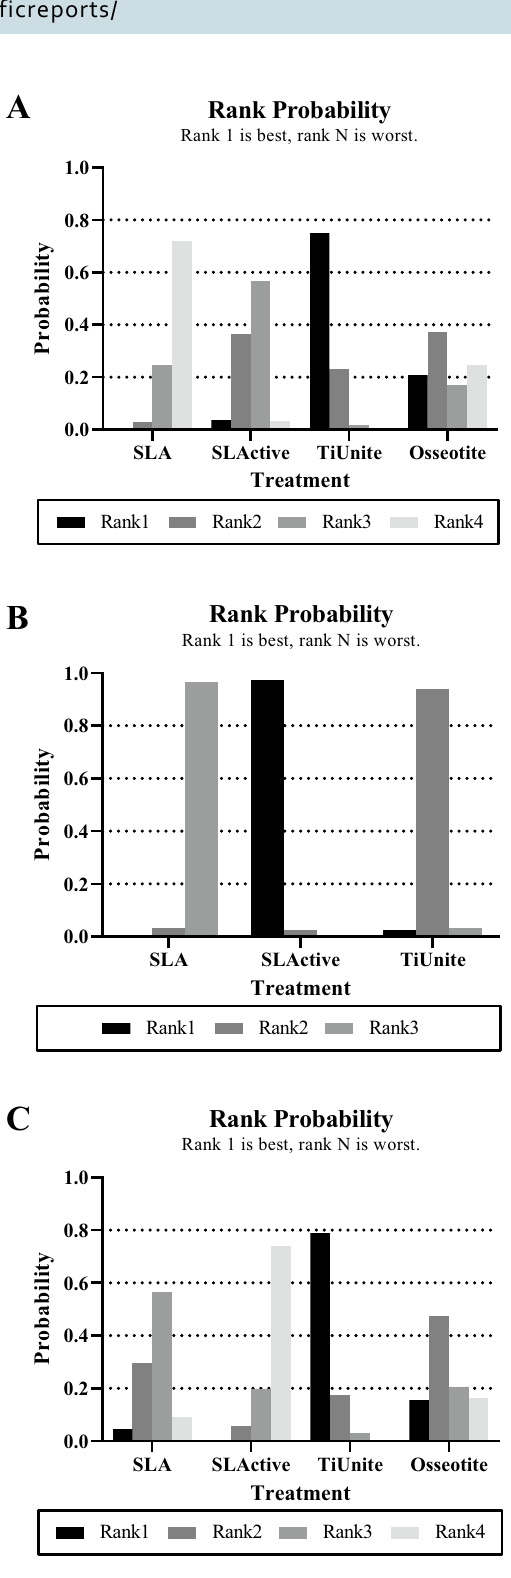
Figure 4. Rank probability plot of four titanium implant surfaces. ( A ) BIC value of final healing stage; ( B ) BIC value of early healing stage; ( C ) ISQ value of final healing